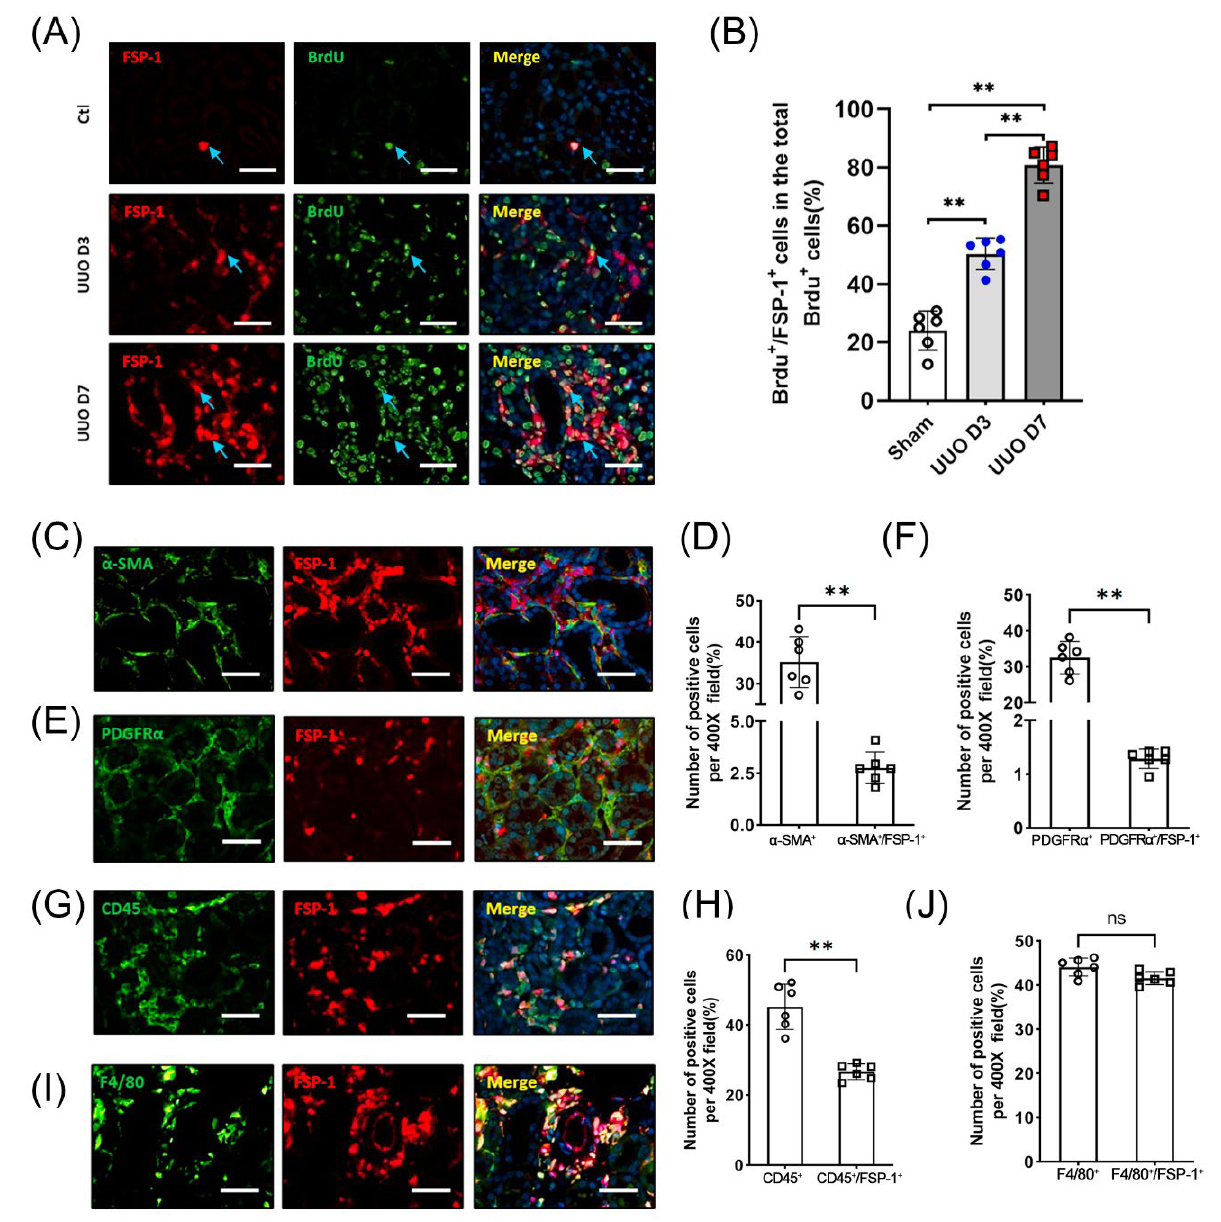
Figure 2. FSP-1 is not a specific marker for myofibroblasts. ( A , B ), Double immunostaining of FSP-1 (red) and BrdU (green) was performed to detect proliferation of FSP-1 + cells in WT mice following UUO on day 3 and 7. Double positive cells (FSP-1 + /BrdU + ) were indicated by arrows (blue) and quantified in Panel ( B ). ( C , D ). Double immunostaining of FSP-1 (red) and α -SMA (green) in the obstructed kidneys. The percentage of the number of all α -SMA + cells and α -SMA + /FSP-1 + cells in the obstructed kidneys was shown. ( E , F ). Double immunostaining of FSP-1 (red) and PDGFR α (green) in the obstructed kidneys. The percentage of the number of all PDGFR α + cells and PDGFR α + /FSP-1 + cells in the obstructed kidneys was shown. ( G , H ). Double immunostaining of FSP-1 (red) and CD45 (green) in the obstructed kidneys. The percentage of the number of all CD45 + cells in the CD45 + /FSP- 1 + cells was shown. ( I , J ). Double immunostaining of FSP-1 (red) and F4/80 (green) in the obstructed kidneys. The percentage of the number of all F4/80 + cells and F4/80 + /FSP-1 + cells in the obstructed kidneys was shown. BrdU, 5-bromodeoxyuridine; PDGFR, platelet-derived growth factor receptor; SMA, smooth muscle actin. Bar = 50 µ m in panels ( A , C , E , G , I ); data are expressed as mean ± SEM, n = 6 mice. (**, p < 0.005; ns, no